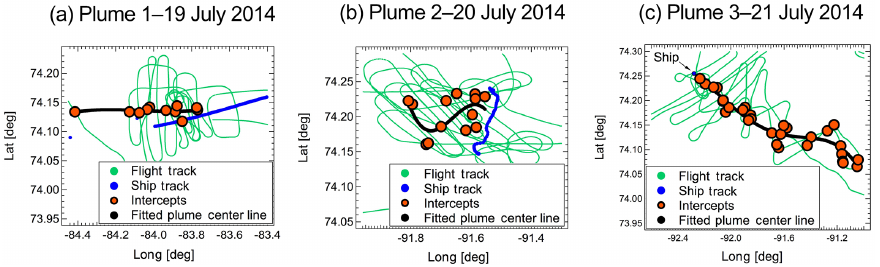
Figure 6. Plume location according to aircraft intercepts along the flight track identified as enhancements above background NO x mixing ratio. The plume locations identified here are in agreement with normalized FLEXPART-WRF predicted partial columns in Fig.